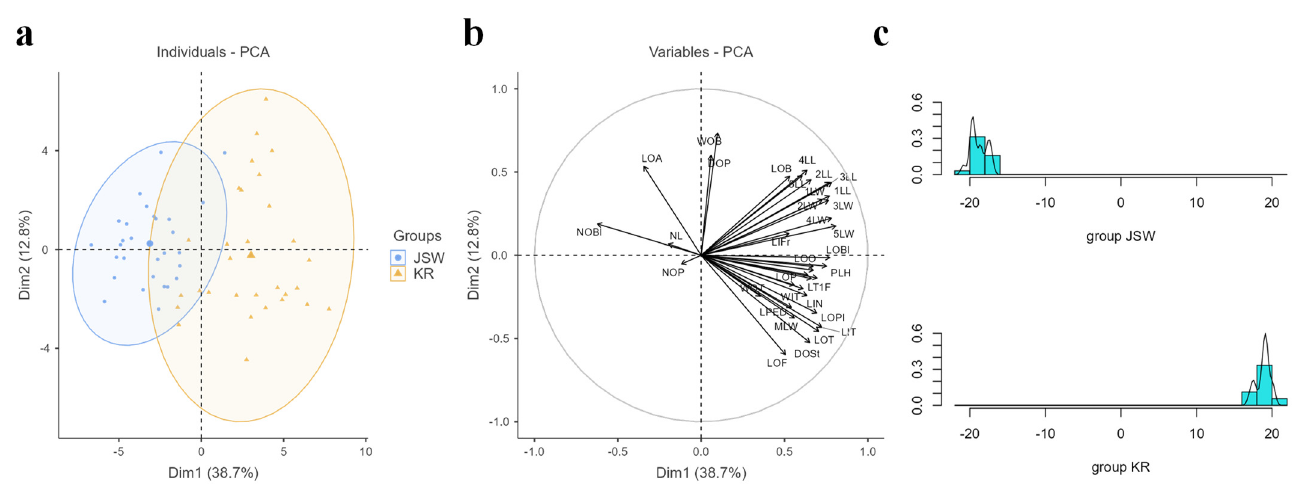
Figure 4. PCA plots and linear discriminant analysis. ( a ). PCA individual plot based on traits 1–36 traits in Table S1. ( b ). PCA variable plot. ( c ). Linear discriminant analysis showed distinct separation between JSW and KR L. leichtlinii